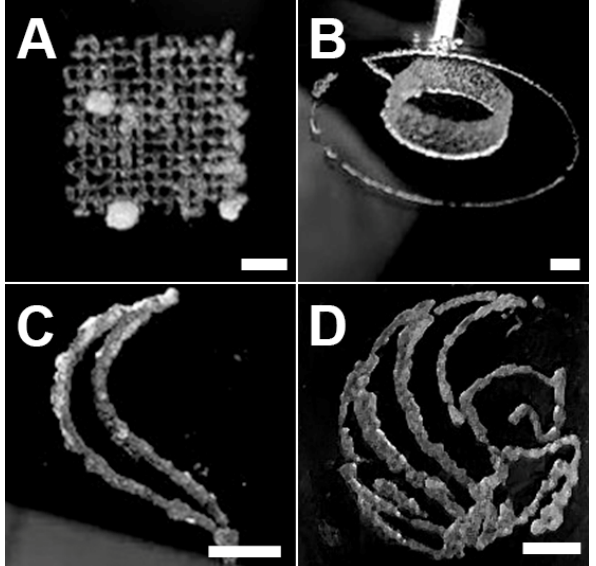
Figure 4. Capgel biomaterial ink can be used to print 3D structures of varying complexity. Images of ( A ) a 10 mm × 10 mm weave/mesh pattern; ( B ) a 10 mm-diameter cylindrical structure; ( C ) a single feather of the Pegasus graphic; and ( D ) a 10 mm-diameter Pegasus graphic. Scale bar = 2.5 mm for all.